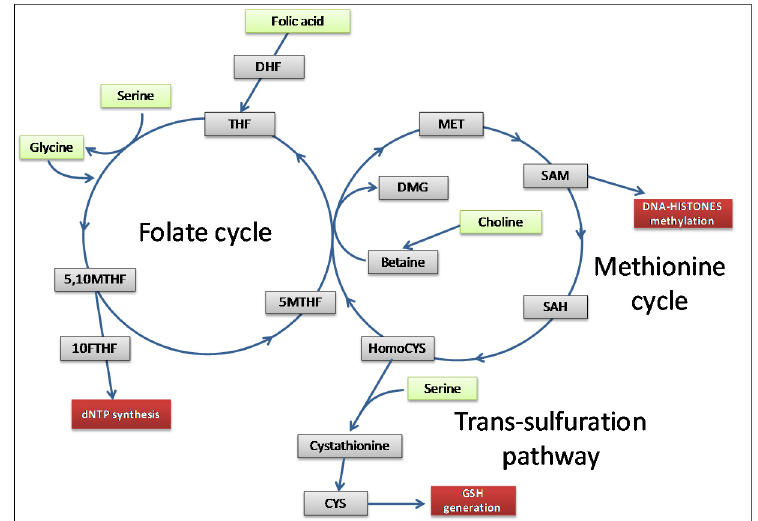
Figure 1. Simplified overview of the main fluxes involved in one ‐ carbon metabolism (inspired by reference [44]). One ‐ carbon cycles act as a biochemical network to sustain fundamental physiological functions, overall DNA and histone methylation, dNTP synthesis, and GSH generation (red rectangles). Several molecular inputs (green rectangles) actively fuel the pathway, generating a number of intermediate metabolites (grey rectangles) through which carbon units are cycled.